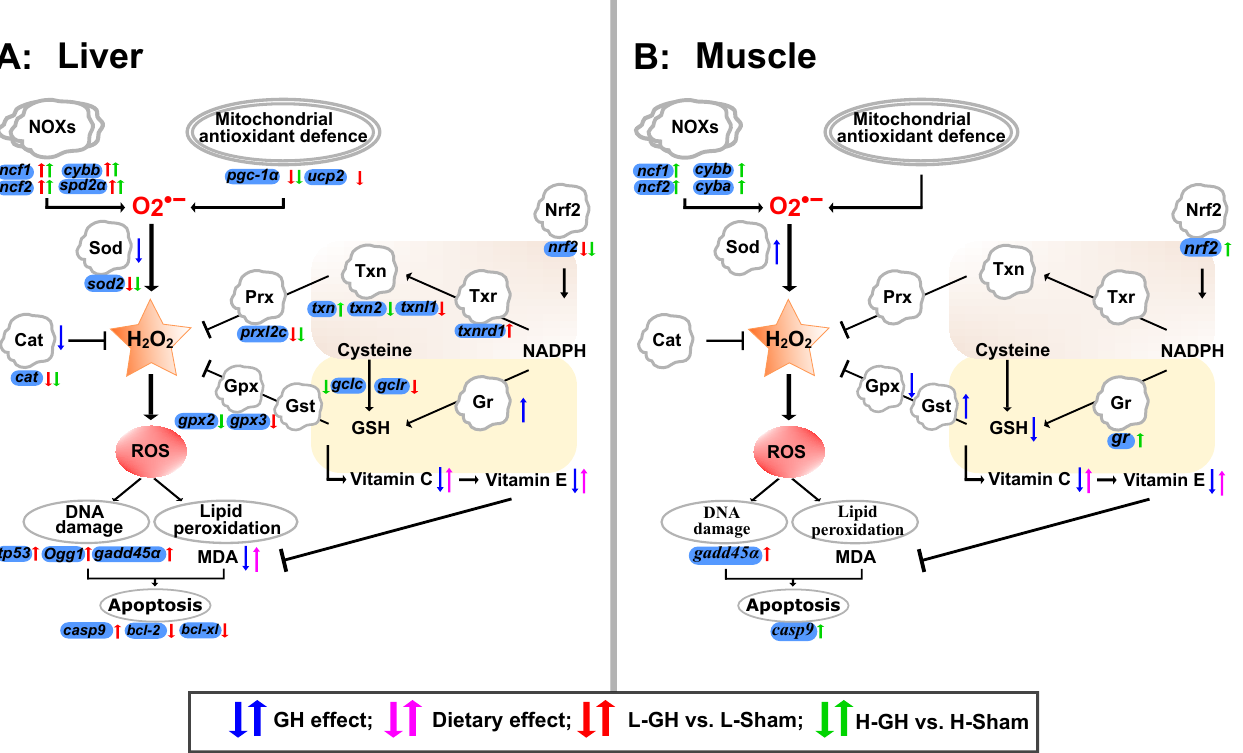
Figure 9. Effect of GH and vitamin C and E nutrition on the redox system in liver ( A ) and muscle ( B ) of Atlantic salmon during the EP2. The systemic overview of redox regulation was raised based on the results in this study. Arrows in blue color represent the regulation of antioxidants by GH, in pink color represent the regulation of antioxidants by dietary vitamin C and E. Arrows in red and green color represent the regulation of redox relative gene expression of the comparisons of L-GH vs. L-Sham and H-GH vs. H-Sham,